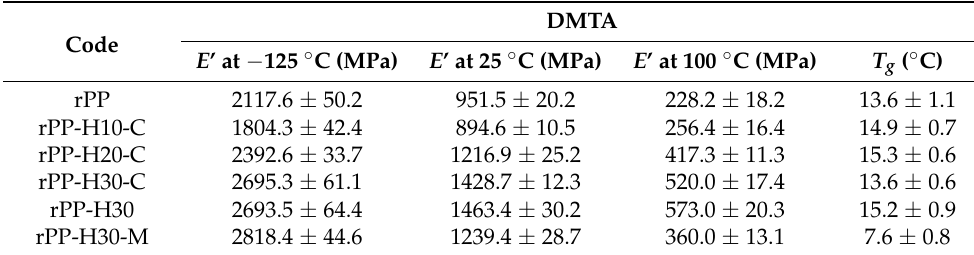
Table 5. Thermomechanical parameters of rPP pieces and the rPP/hemp fiber composites